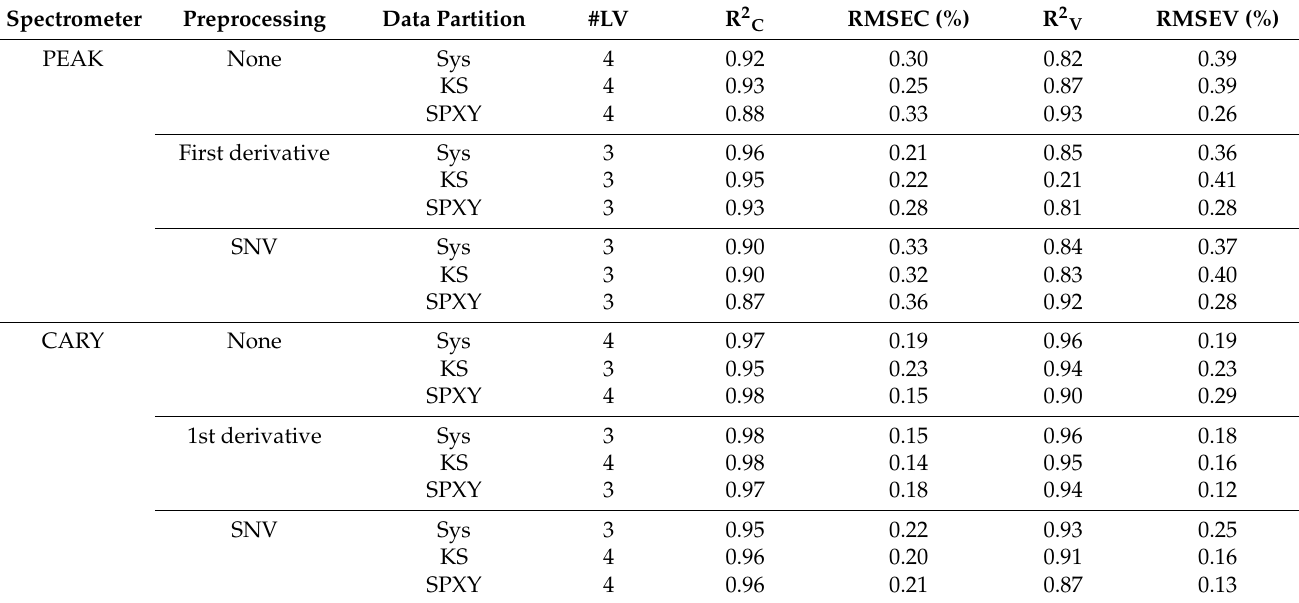
Table 4. Validation performance of moisture predictive models established based on a portable NIR spectrometer (PEAK) and a benchtop spectrometer